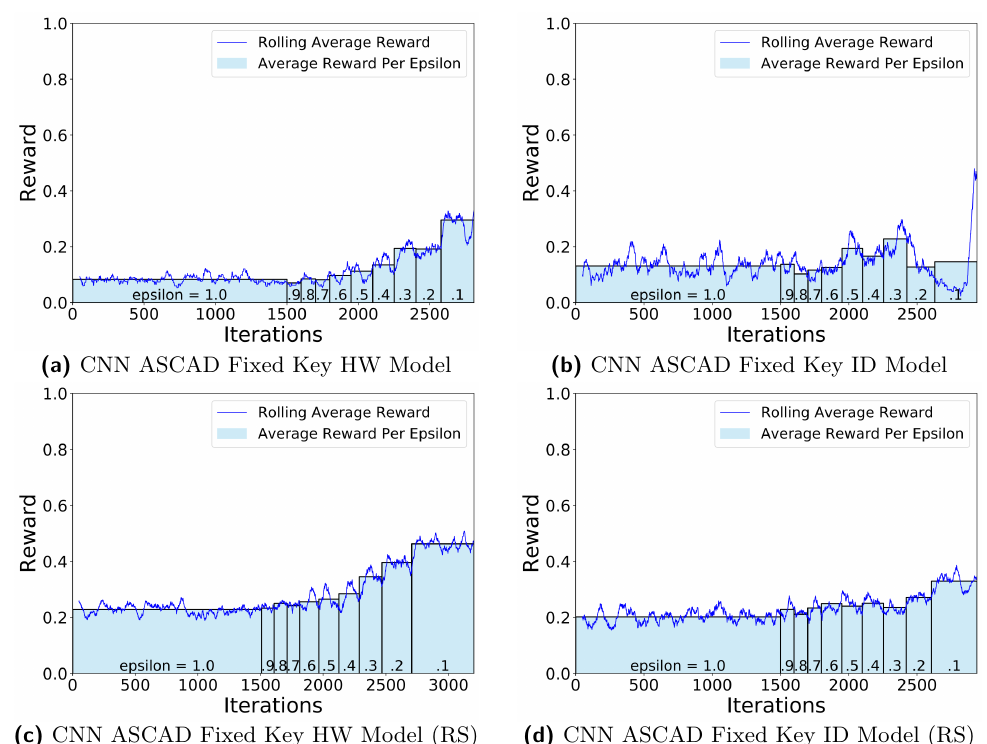
Figure 6: An overview of the Q-Learning performance for the ASCAD with fixed key dataset experiments. The black line indicates the rolling average of the Q-Learning reward for 50 iterations, where at each iteration, we generate and evaluate a neural network architecture. The bars in the graph indicate the average Q-Learning reward for all neural network architectures generated during that ε .